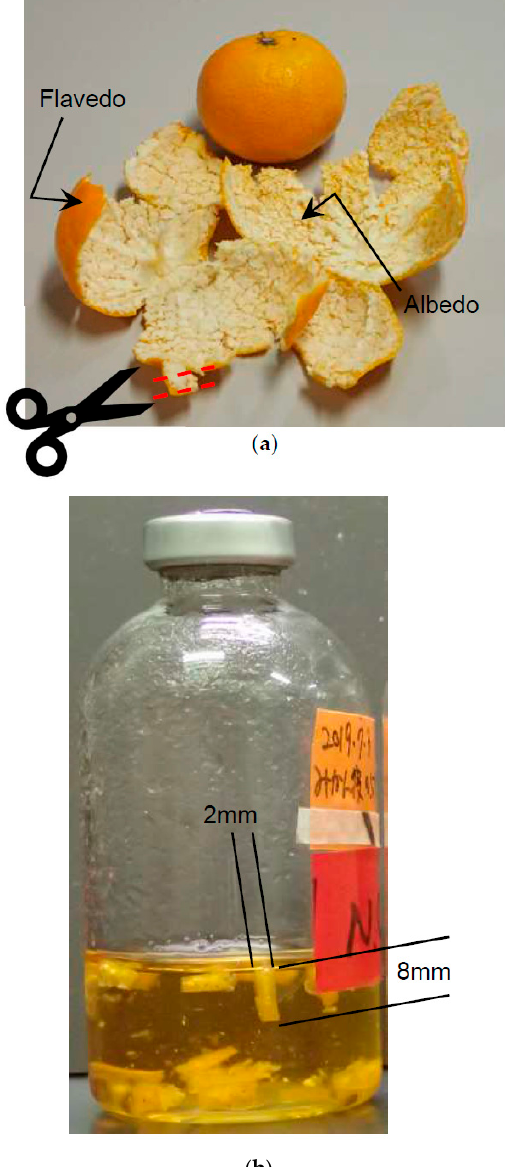
Figure 2. ( a ) Removed peel before cutting, ( b ) Strips of removed peel in the medium.